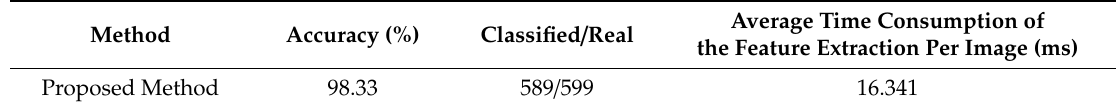
Table 15. Experiment with the original images test